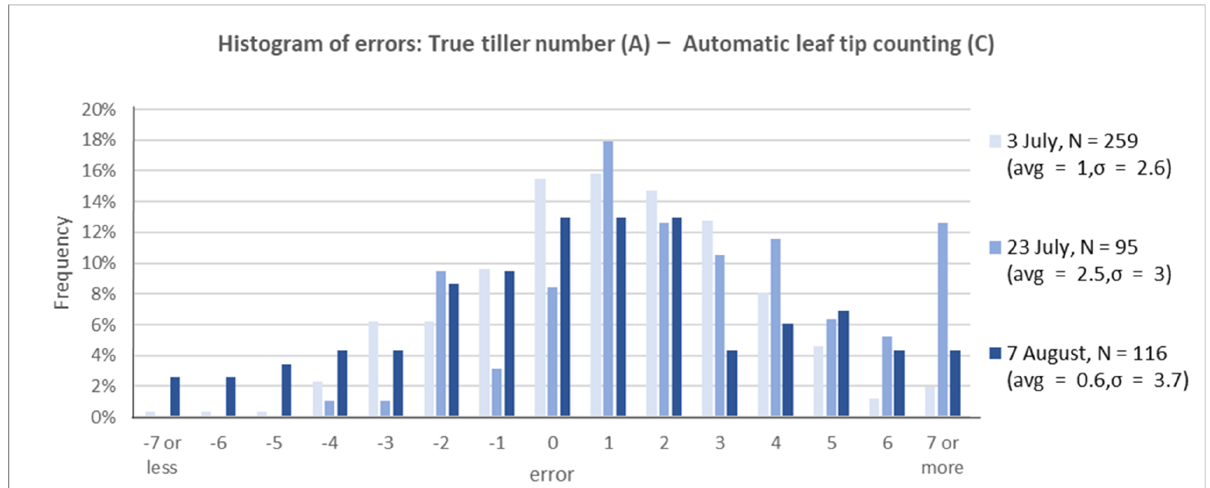
Figure 10. Error histogram between true tiller number and automatically counted leaf-tip number. The statistics of the observation results are described below (Table 2). For correlation